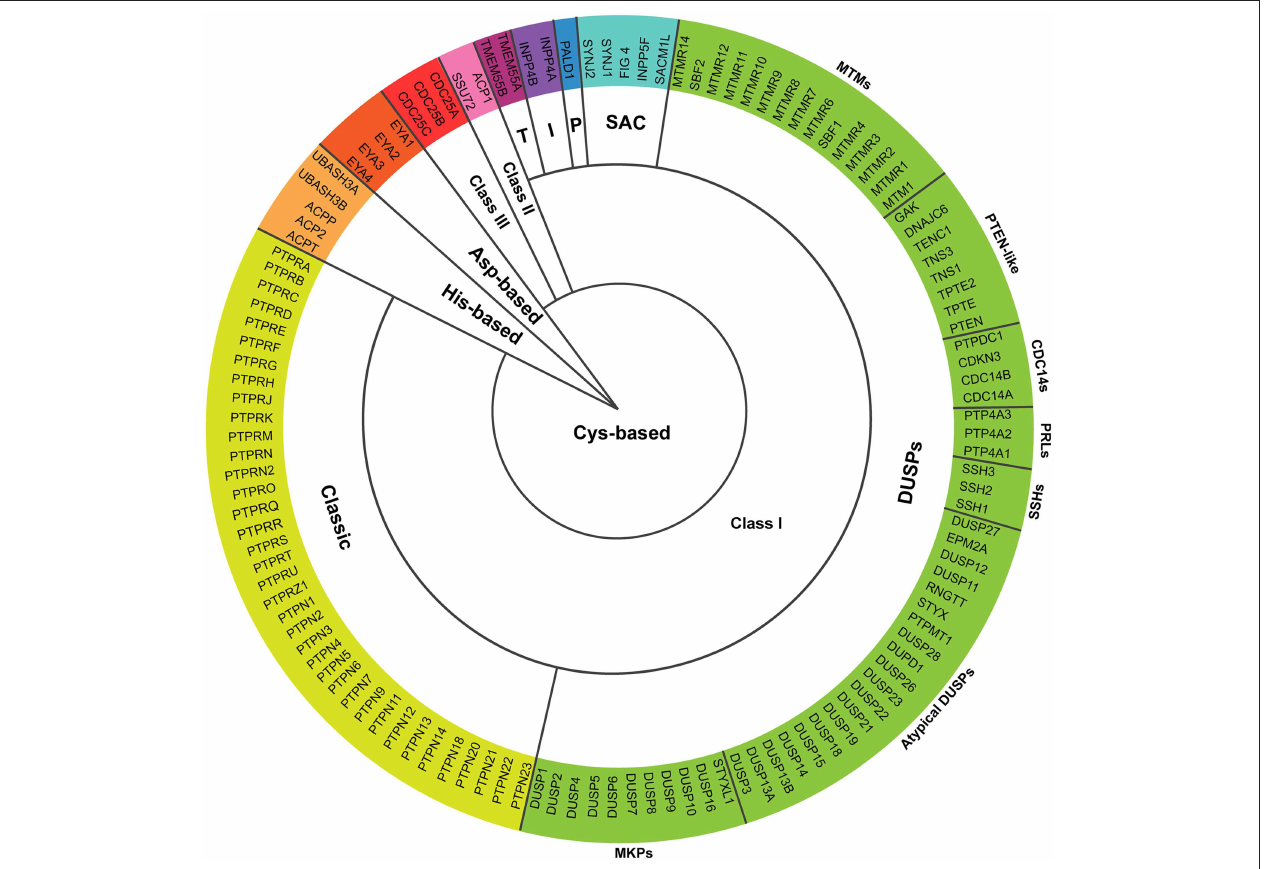
FIGURE 1 | Proteins encoded by the extended PTPome. The schematic represents the 125 protein tyrosine phosphatases encoded by the extended PTPome and their classification following criteria by Alonso and Pulido ( 2). DUSPs, dual-specificity PTPs; MKPs, MAP kinase phosphatases; SSHs, slingshots; PRLs, phosphatases of regenerating liver; CDC14s, cell division cycle-14 proteins; PTEN, phosphatase and tensin homolog; MTMs, myotubularins; P, paladin; I, INPP4 phosphatases; T, TMEM55 phosphatases; CDC25, cell division cycle-25